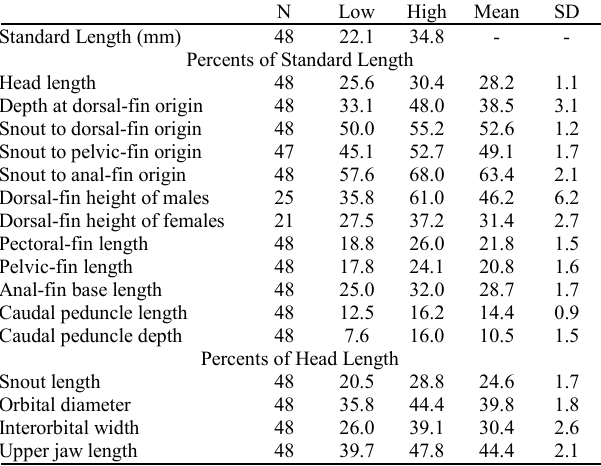
Table 2. Morphometric data of Hyphessobrycon loweae , based on the paratypes (MZUSP 45749, 2 x.; MZUSP 45750, 1 ex.; MZUSP 45751, 1 ex); and on non-type specimens (MZUSP 97435, 1 ex.; MZUSP 95611, 3 ex.; MZUSP 101404, 13 ex.; MZUSP 97693, 1 ex.; MZUSP 102816, 14 ex.; MZUSP